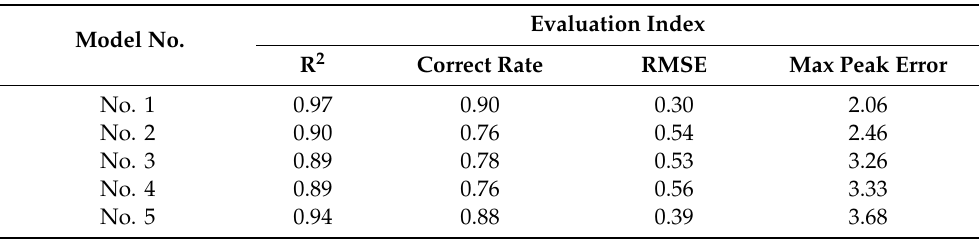
Table 8. Evaluation index value of each model (the case where one CRAC suddenly stops while only one CRAC is operating).